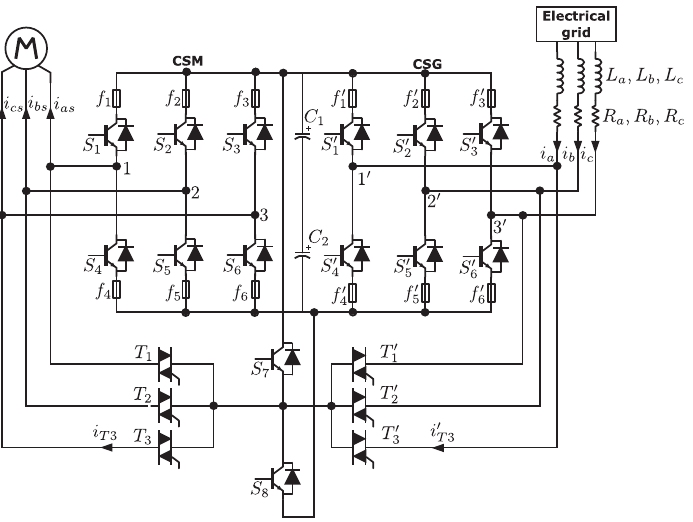
Figure 12. Fault-tolerant WECS topology with DFIG. The redundant switches S 7 and S 8 , replace the faulty leg in case of a failure on the primary or motor converter side.